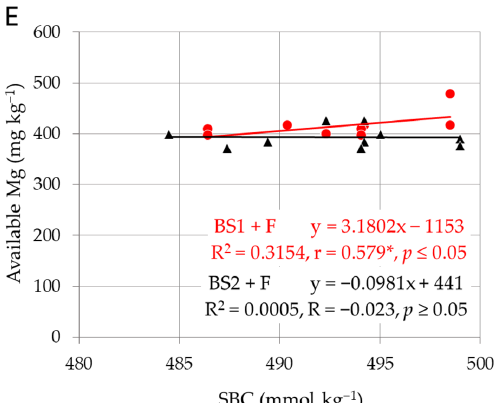
Figure 3. The linear dependence between selected soil properties and Ca availability for chosen treatments in sandy soil: ( A ) Soil pH in nonfertilized treatments; ( B ) Sum of basic cations (SBC) in fertilized treatments; ( C ) Cation exchange capac- ity (CEC) in fertilized treatments. The linear dependence between selected soil properties and Mg availability for chosen treatments in loamy soil: ( D ) Soil pH in fertilized treatments; ( E ) Sum of basic cations (SBC) in fertilized treatments. Red circles and * indicate correlation at p ≤ 0.05.